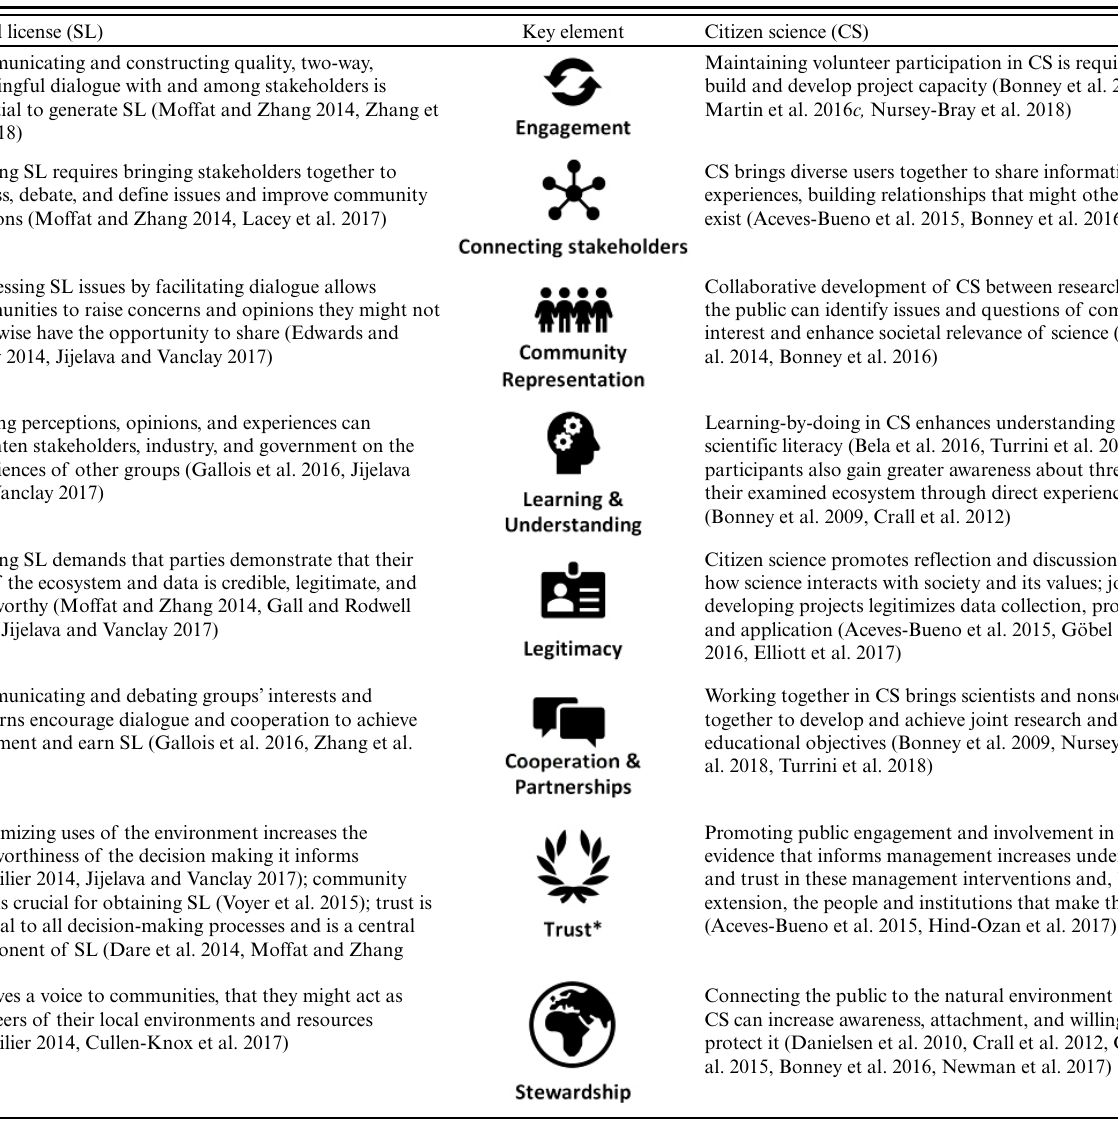
Table 1. Synthesis of key elements common to social license and citizen